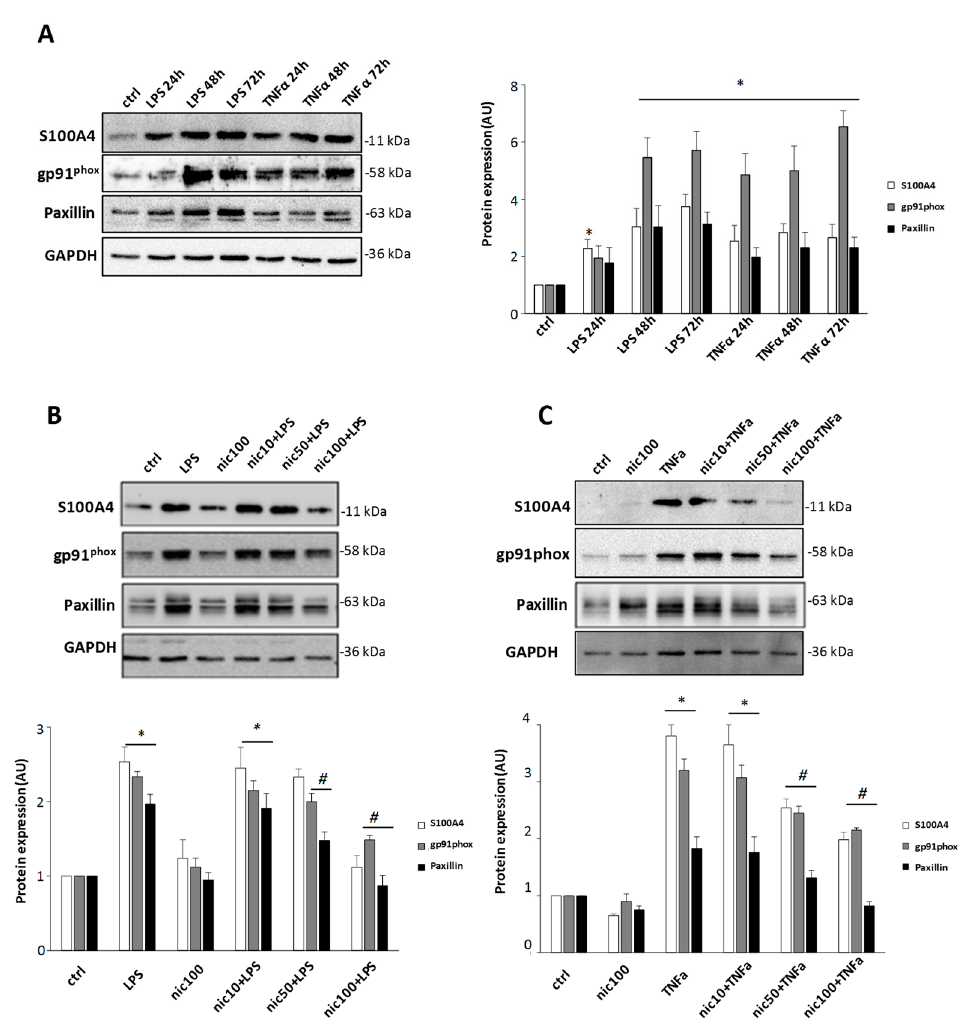
Figure 1. Niclosamide prevents the increase of S100A4, gp91 phox , and paxillin in LPS- and TNF α stimulated primary microglia. ( A ) Primary microglia were treated with 1 μ g/mL LPS or 50 ng/mL TNF α for 24, 48, or 72 h or non-treated (ctrl). Protein lysates were analyzed by western blot using anti-S100A4, anti-gp91 phox , anti-paxillin, and anti-GAPDH antibodies. Primary microglia were pre-treated with DMSO (ctrl) or 10 nM, 50 nM, 100 nM niclosamide (nic). After 24 h, cells were stimulated with 1 μ g/mL LPS ( B ) or 50 ng/mL TNF α ( C ) for 48 h. Protein lysates were analyzed by western blot using anti-S100A4, anti-gp91 phox , anti-paxillin, and anti-GAPDH antibodies. Quantification of protein bands normalized to GAPDH and relative to control is expressed in an arbitrary unit (AU). Data are reported as mean ± S.E.M. (n = 3 independent experiments). Statistical significance was calculated by ANOVA followed by Post Hoc Tukey’s test. * p < 0.05 relative to control ( A – C ), # p < 0.05 relative to LPS ( B ) or TNF α ( C ).